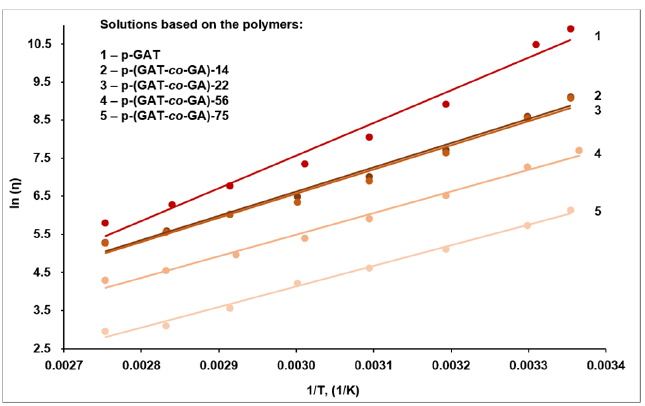
Figure 5. The viscosity of the p ‐ GAT and p ‐ (GAT ‐ co ‐ GA) solutions in the HET plasticizer plotted against temperature.